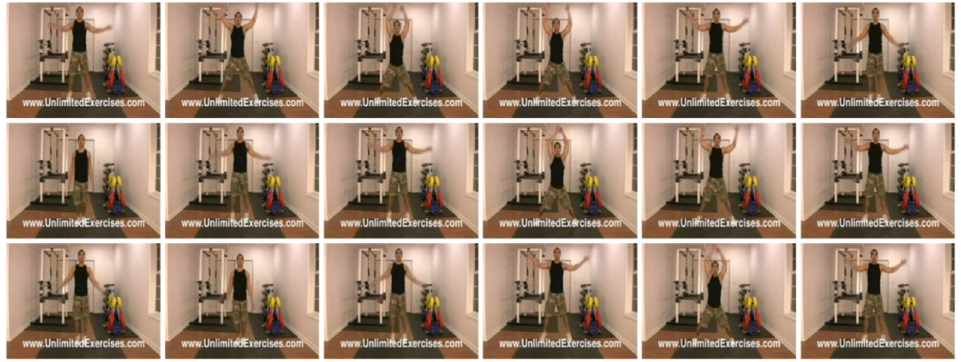
Figure 4. Original Activity Action frames.